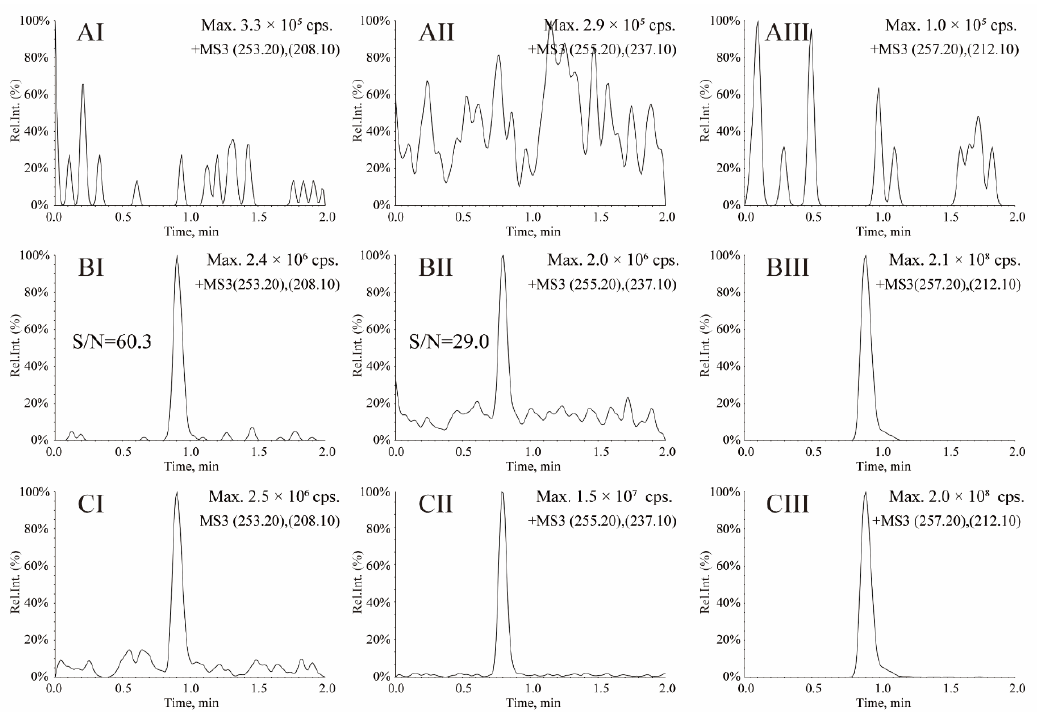
Figure 2. Representative LC-MS 3 chromatograms for oxcarbazepine ( I ), 10-hydroxycarbazepine ( II ) and oxcarbazepine-d 4 ( III ). ( A ) Blank human serum; ( B ) blank human serum spiked with oxcarbazepine at 25 ng/mL of LLOQ ( BI ), 10-hydroxycarbazepine at 0.5 µg/mL of LLOQ ( BII ) and 5.0 µg/mL of IS ( BIII ); ( C ) a serum sample from a patient with epilepsy after oral administration of oxcarbazepine.